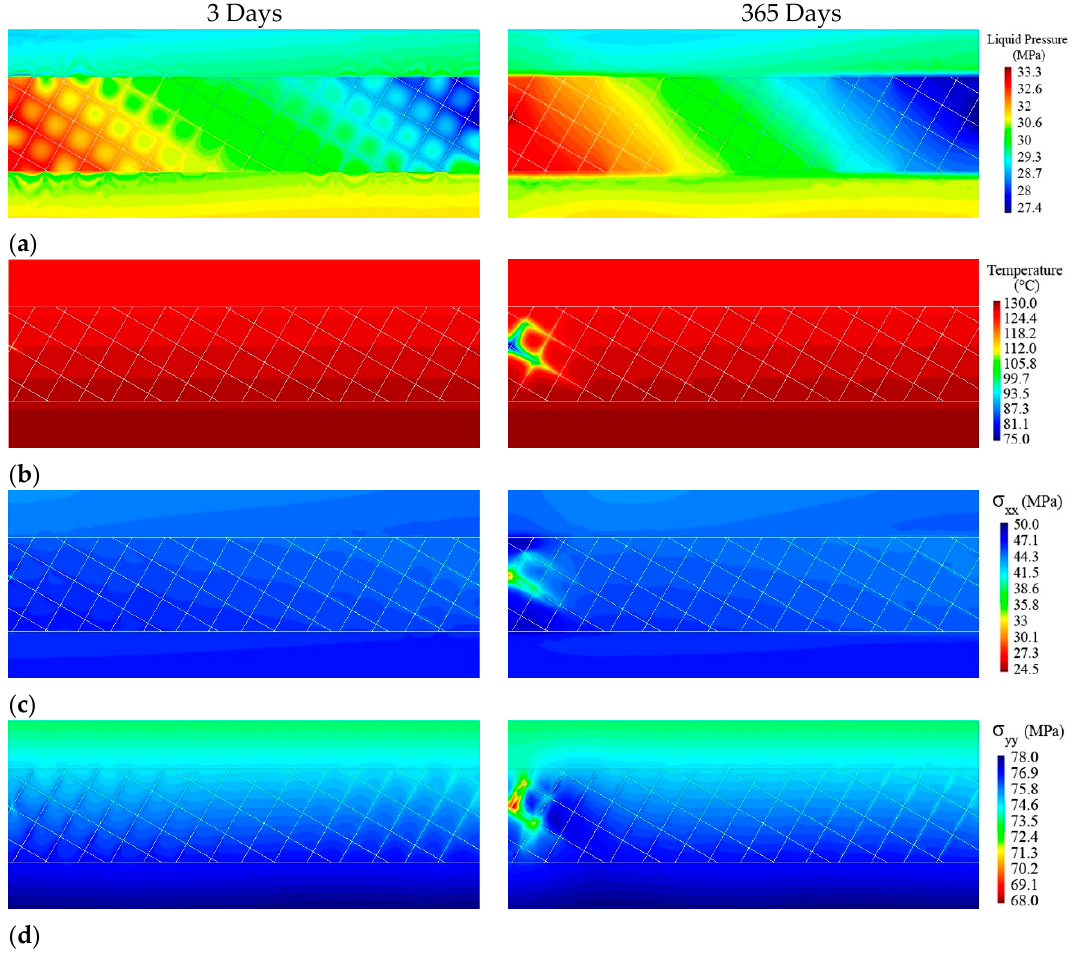
Figure 12. Distribution of ( a ) liquid pressure, ( b ) temperature, ( c ) horizontal total stresses, and ( d ) vertical total stress for low-temperature fluid injection after 3 and 365 days of injection and production for fractures with intrinsic permeability of 10 − 12 m 2 .